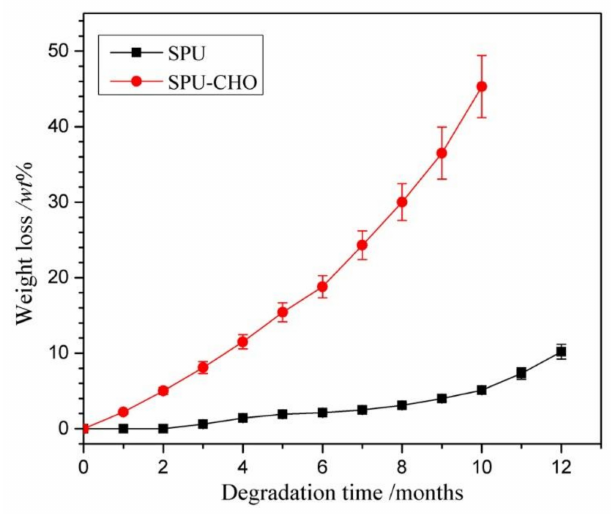
Figure 6. Degradation behaviors of the SPU and SPU-CHO films in PBS ( n = 5).